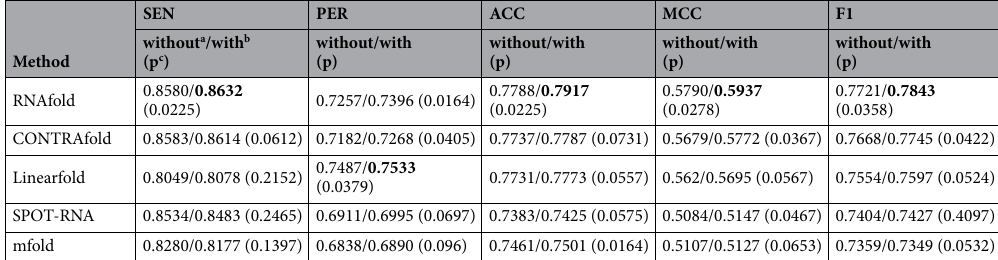
Table 5. Performance comparison among different methods on dataset TS’ (see Table 1). a Prediction without RNA-par, b prediction with RNA-par, c p value. The number in bold indicates the highest value in each metrics.